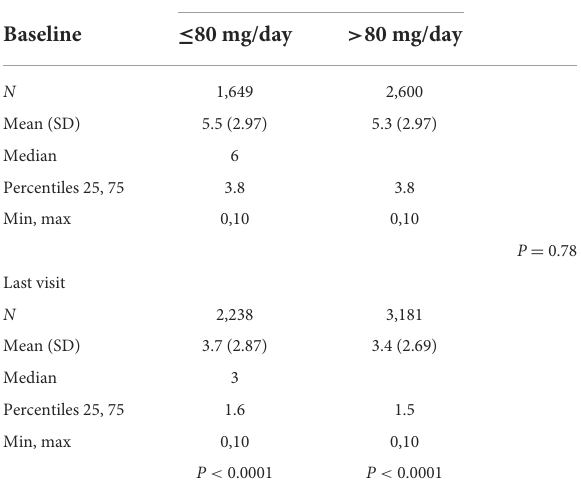
TABLE 4B Alcohol craving for the overall population – maximum recorded